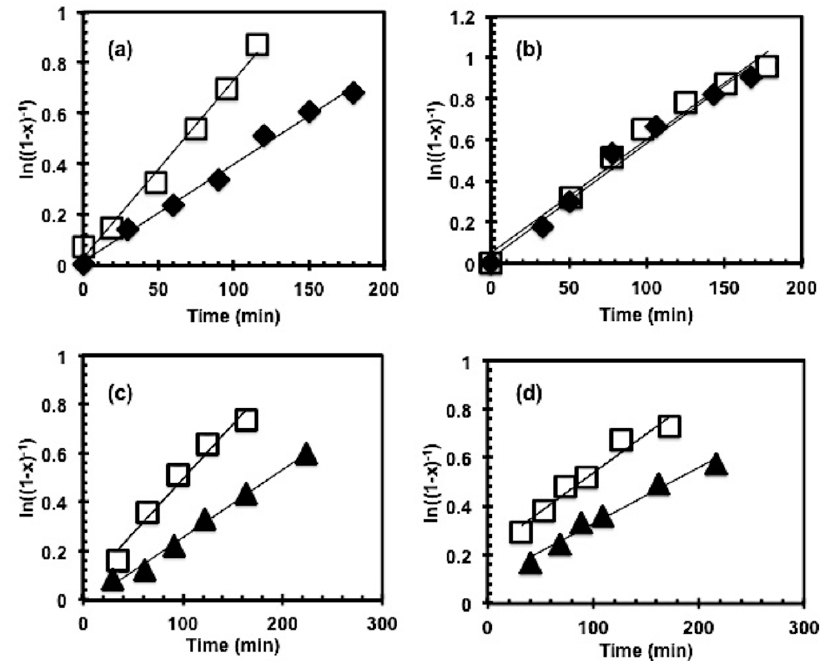
Figure 1. The kinetic plots of ln[(1- x ) −1 ] ( x = conversion) versus polymerization time for NLAM/X (X = p-acetoxystyrene (AcOST), styrene (ST), 2-vinyl naphthalene (VN) or pentafluorostyrene (PFS)) random copolymerization initiated by BlocBuilder ® in 1,4 dioxane solution at 90 °C: ( a ) NLAM/AcOST-5 ( □ ), NLAM/AcOST-10 ( ■ ); ( b ) NLAM/ST-5 ( □ ), NLAM/ST-10 ( ■ ); ( c ) NLAM/VN-5 ( □ ), NLAM/VN-10 ( ▲ ); ( d ) NLAM/PFS-5 ( □ ), NLAM/PFS-10 ( ▲ ). The straight solid lines are the best linear fit of the experimental data